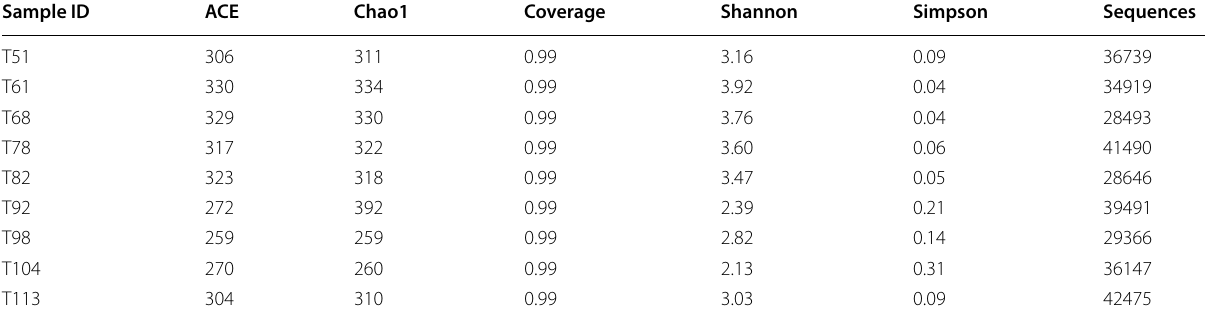
All values were calculated at 0.03 distance limit